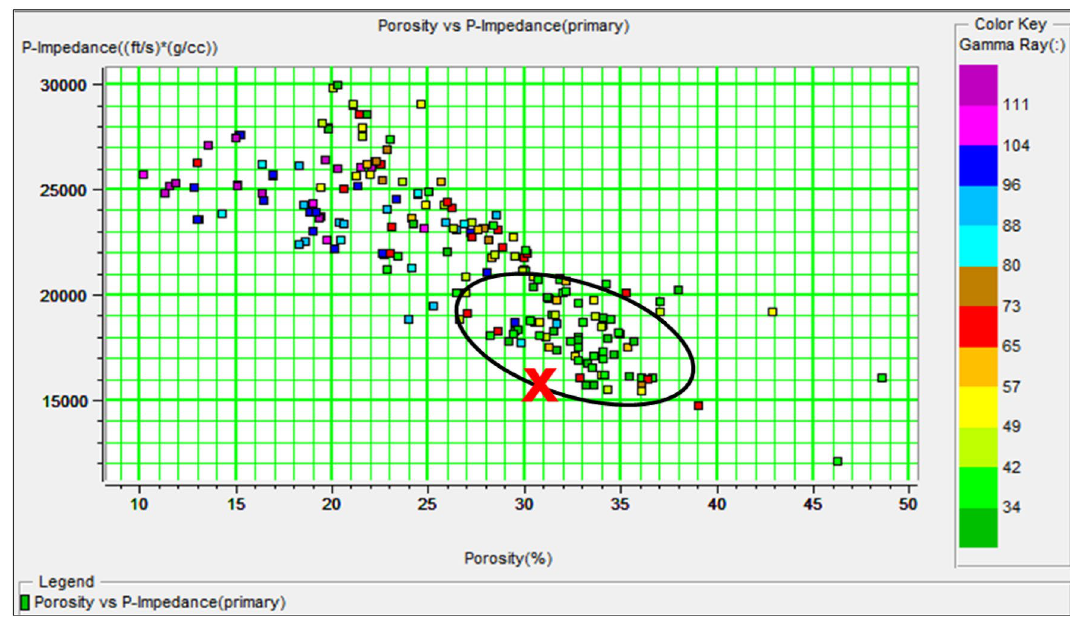
Fig. 7 Crossplot of reservoir porosity and acoustic impedance with gamma ray in reservoir R1, well 1